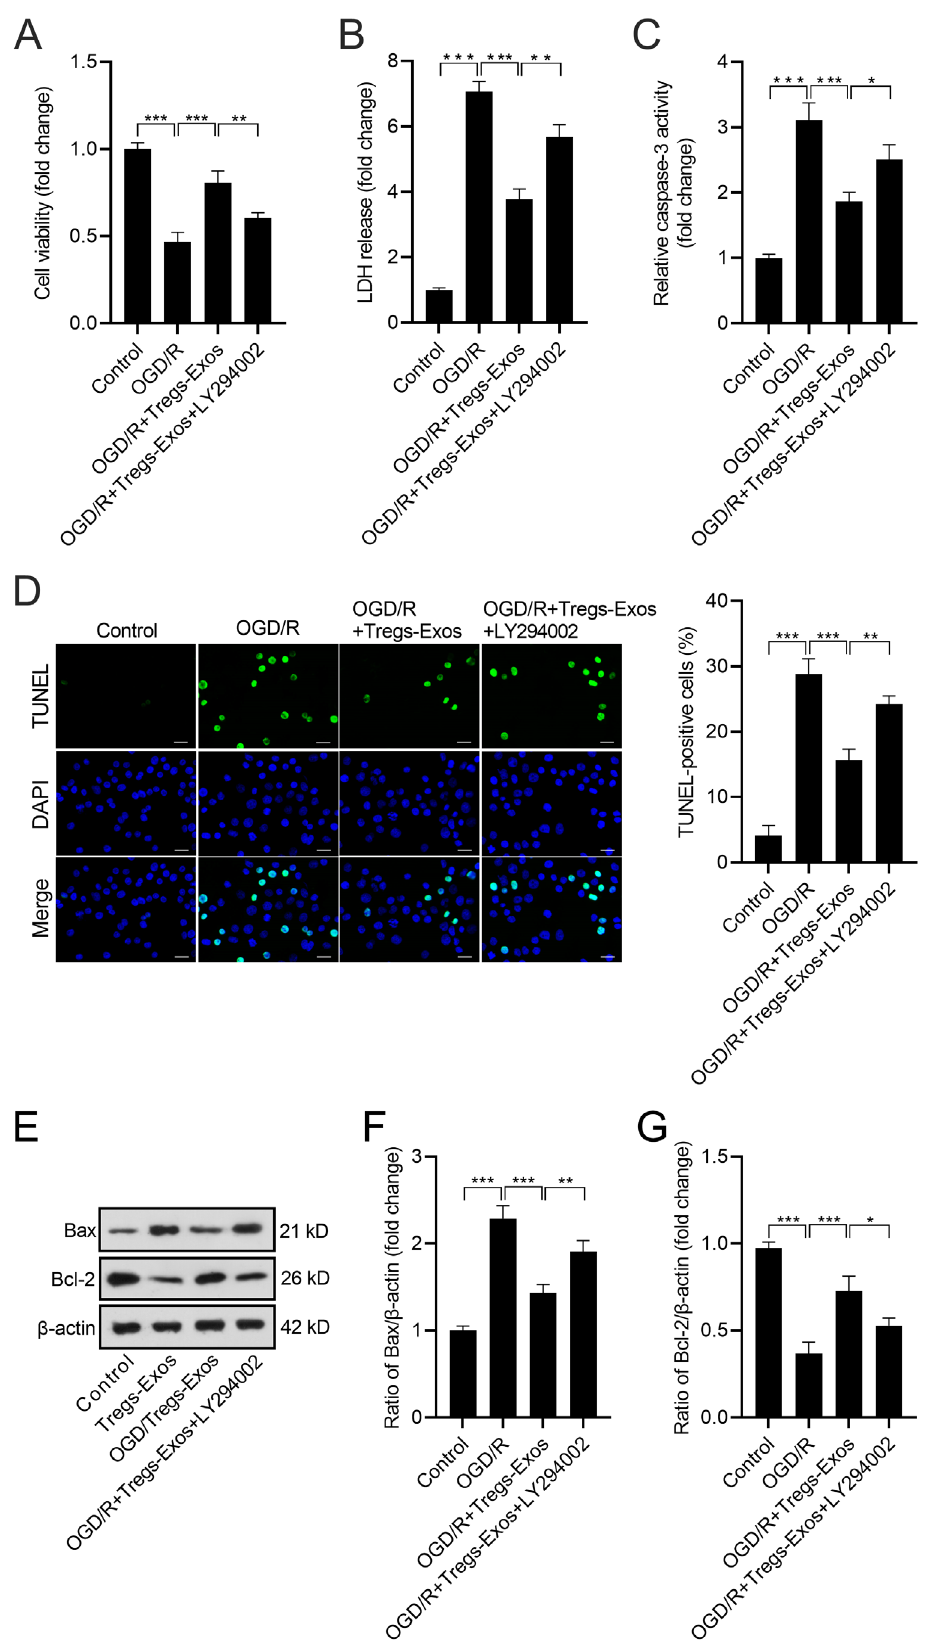
Figure 5 – LY294002 attenuates the effect of Tregs-Exos on OGD/R-induced cell apoptosis in BV-2 microglia. (A) Cell viability of BV-2 cells was measured by CCK-8 assay. (B) Relative LDH release level in BV-2 cells. (C) Relative caspase-3 activity in BV-2 cells. (D) Apoptotic BV-2 cells were detected by TUNEL assay. Scale bar: 20 μM. (E-G) Protein levels of Bax and Bcl-2 were detected by western blot. * p < 0.05, ** p < 0.01, *** p <